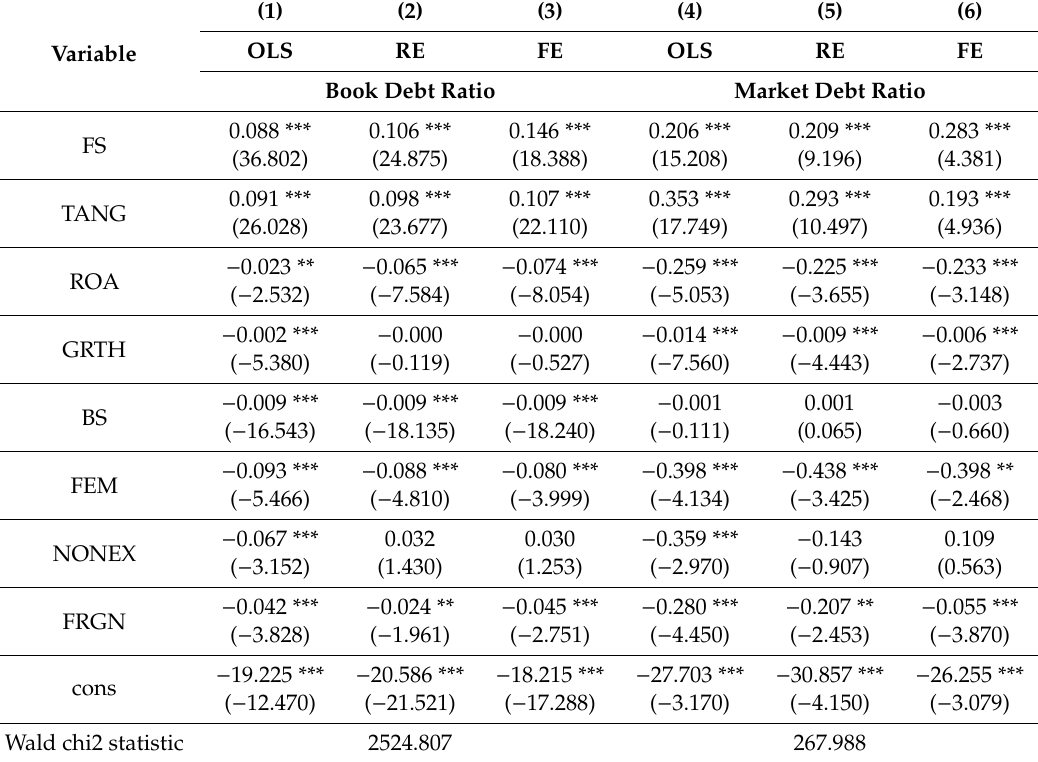
Table 2. Regression analysis for extended model. Table 2 shows the results of regression analysis for an extended model using pooled OLS, fixed e ff ects (FE), and random e ff ects (RE). The dependent variable for models 1–3 is book debt ratio measured by total debt divided by total assets, and for models 4–6, it is market debt ratio measured by total debt divided by market. FS is firm size measured